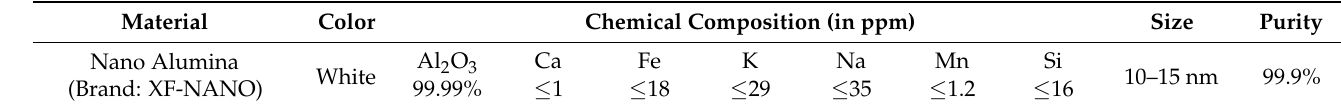
Table 4. Aluminum oxide nanoparticle (Al 2 O 3 , gamma) properties.